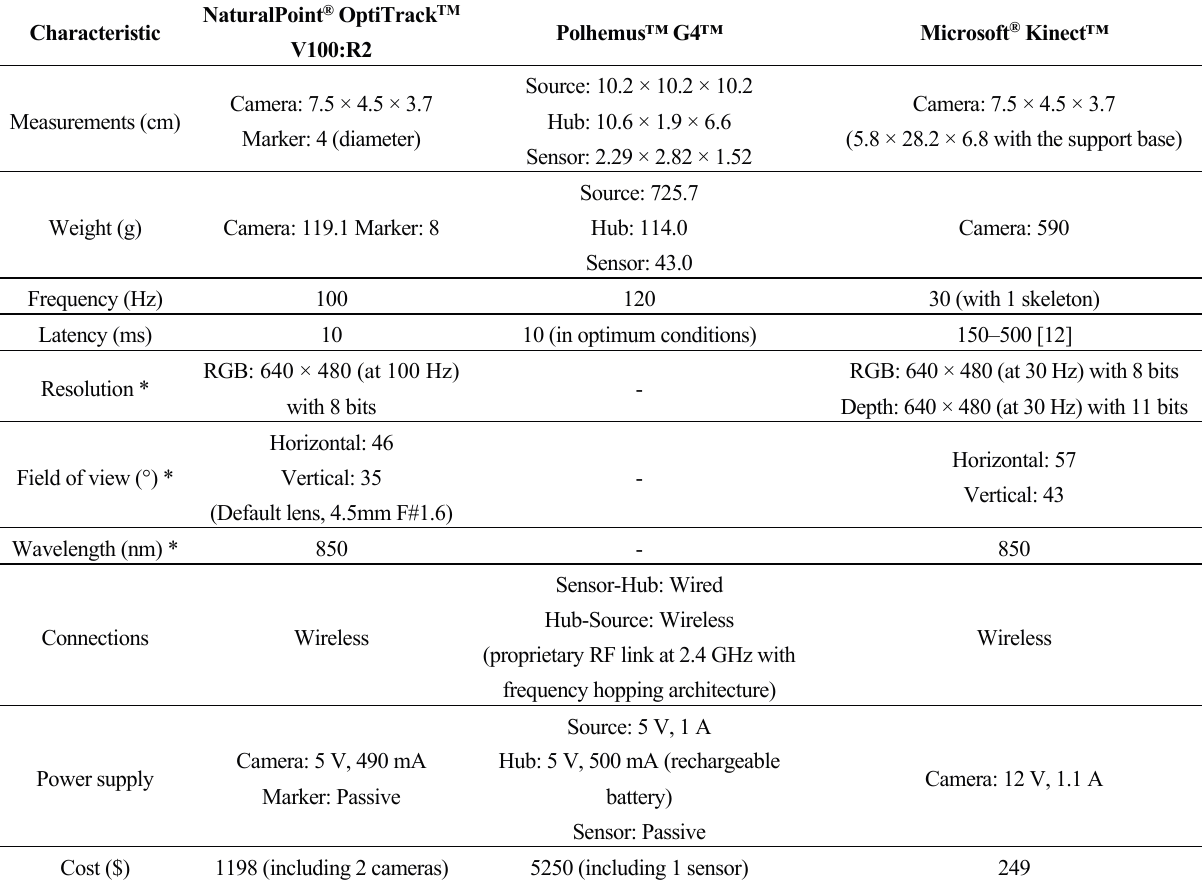
Table 1. Characteristics of the tracking systems under study. The table shows the characteristics of the tracking